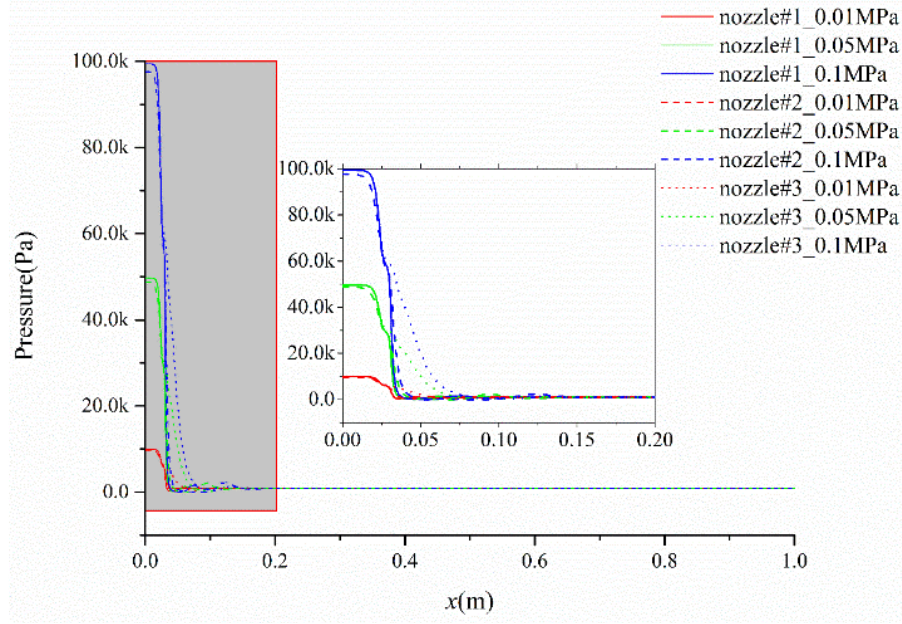
Figure 5. Pressure distribution along the central axis.